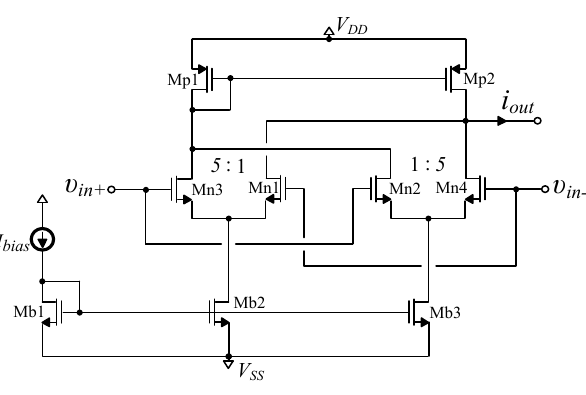
Figure 6. Improved linearity OTA